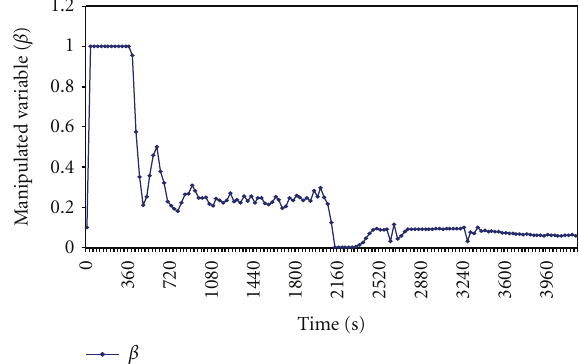
Figure 6: Evolution of the manipulated variable ( β ), K = 0.5, K r = 1. 4th phase: constant temperature set-point at 20 ◦ C during 500